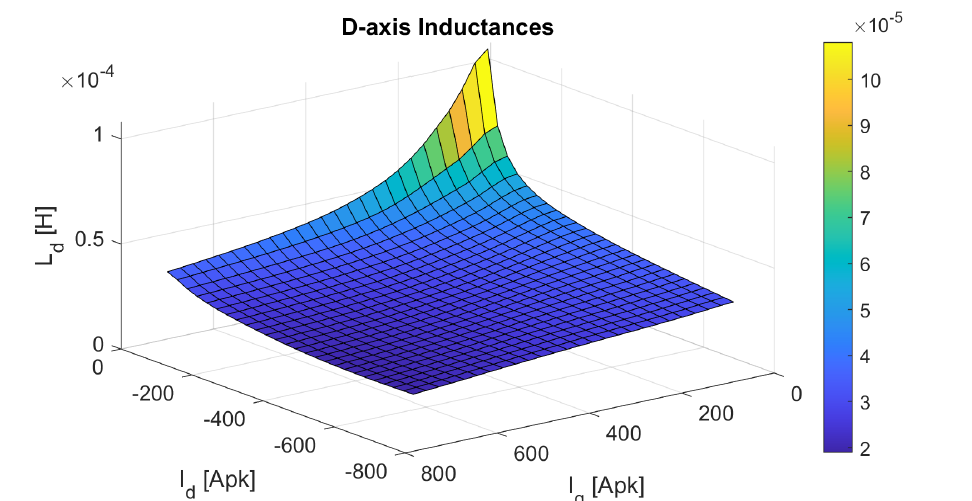
Figure 3. Inductance map of d -axis ( L d ) obtained with the Standard Method.